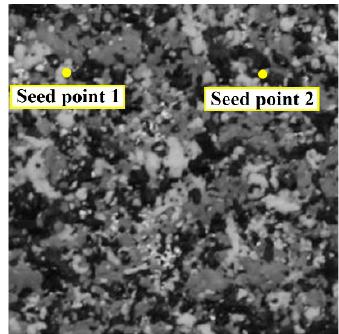
Figure 5. Randomly selected two different seed points within the ROI of the aluminum specimen.